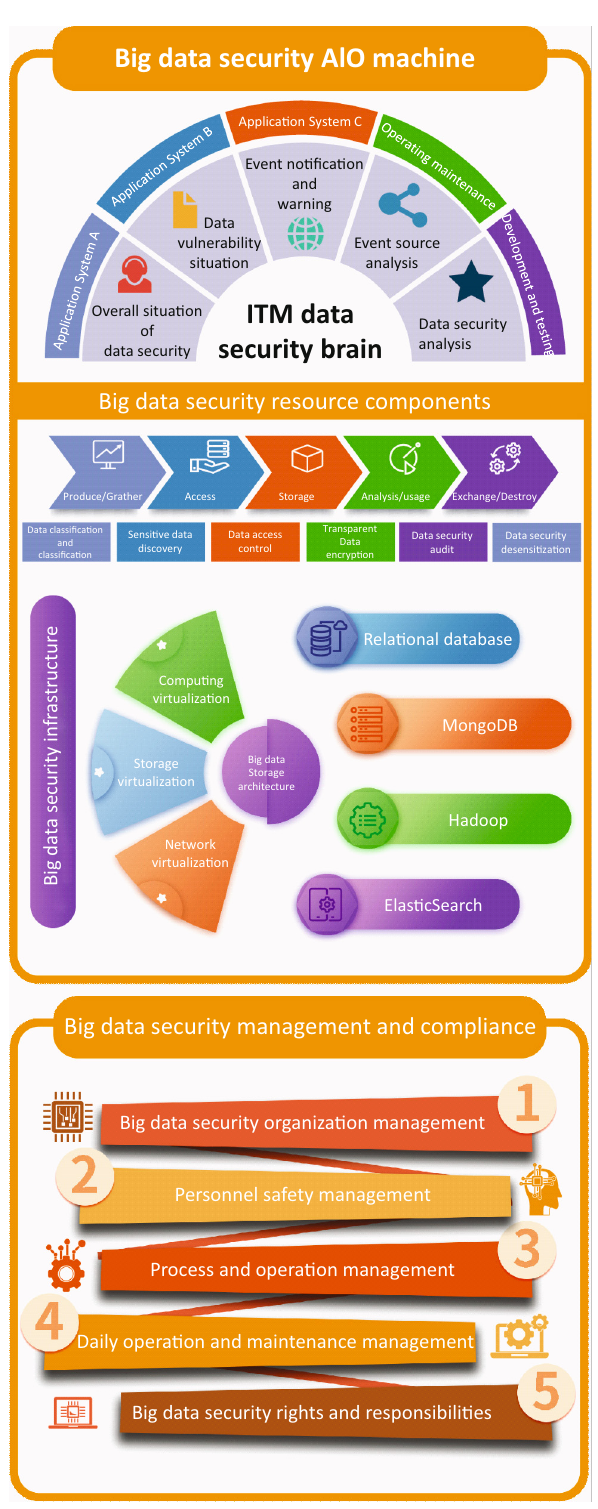
Figure 1: Framework of network security situation